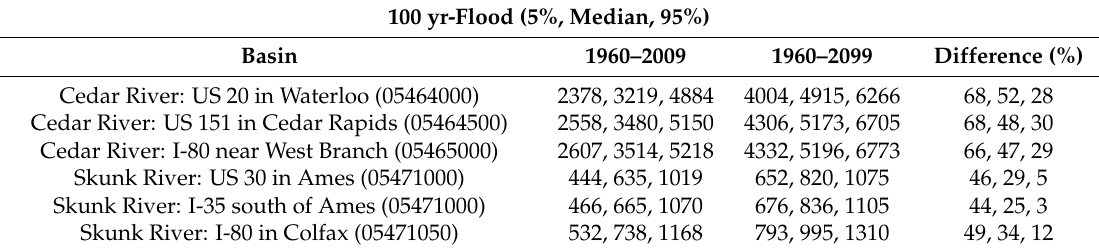
Table 4. Differences in the estimation of the 100-yr flood and their 95% confidence intervals over the periods 1960–2009 and 1960–2099 at the selected bridges.